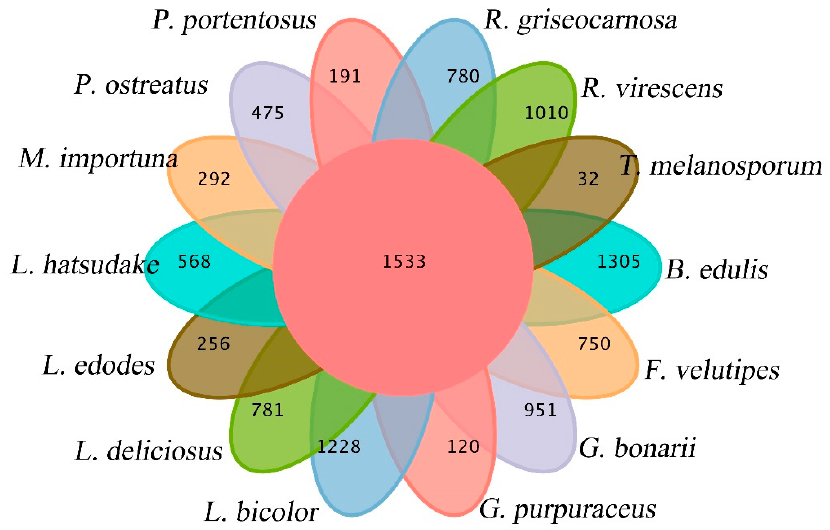
Figure 5. Venn diagram of orthologous gene families. Table 2. Statistical results of the gene families.